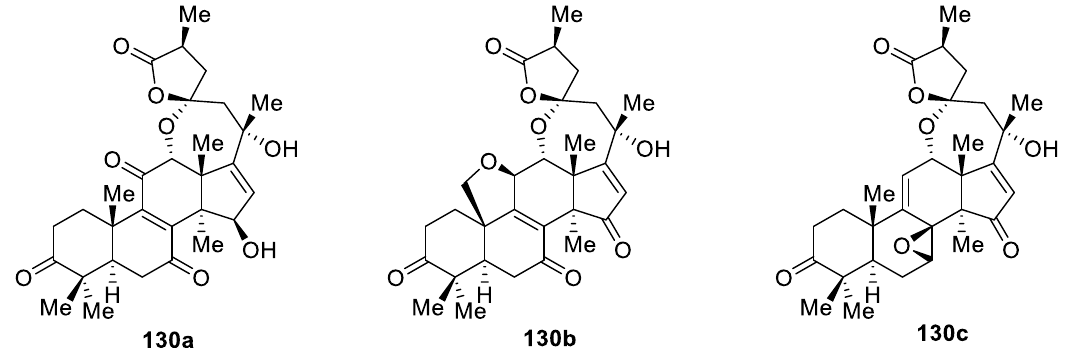
Figure 62. Lanostane-type triterpenoid spirolactones from Ganoderma applanatum .